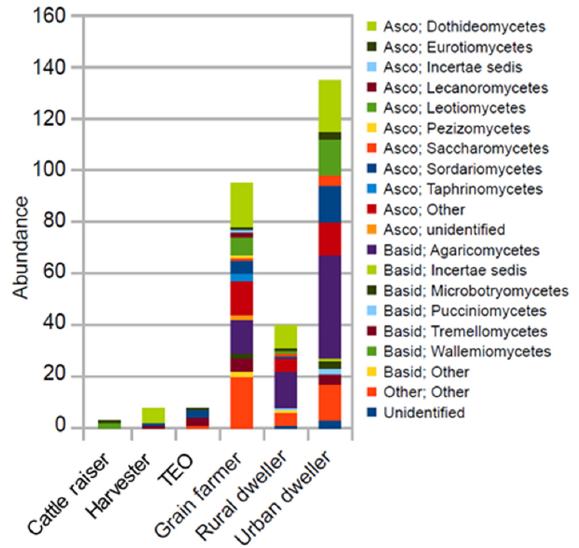
Table 2. Significant differences in the fungal diversity as a function of the period of exposure to wheat dust among worker groups. Results of the pairwise PERMANOVA analysis (Adonis).